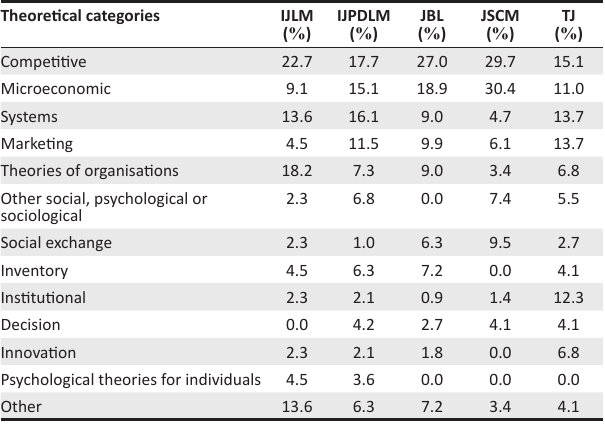
TABLE 5: Frequency of theoretical incidents by journal